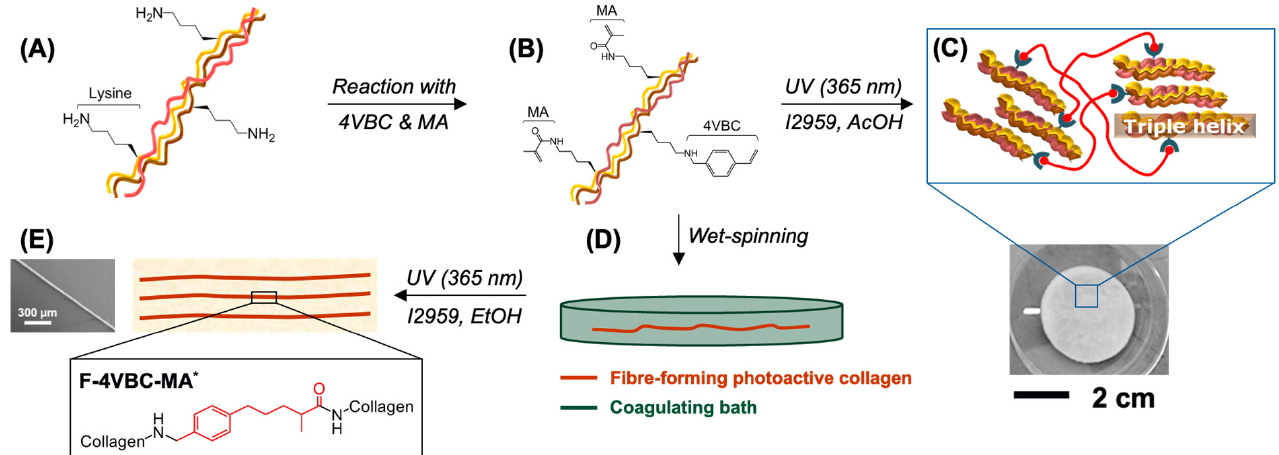
Figure 1. Design of hierarchically assembled type I collagen fibres. Reaction of CRT ( A ) with 4VBC and MA enables covalent coupling of multiple photoactive residues ( B ). UV-curing generates a covalent hydrogel network following solubilisation of the photoactive CRT precursor in the presence of the I2959 photoinitiator ( C ). The photoactive CRT precursor is wet spun against ethanol ( D ) and UV-cured to realise individual fibres with enhanced material integrity and controlled nanoscale organisation ( E